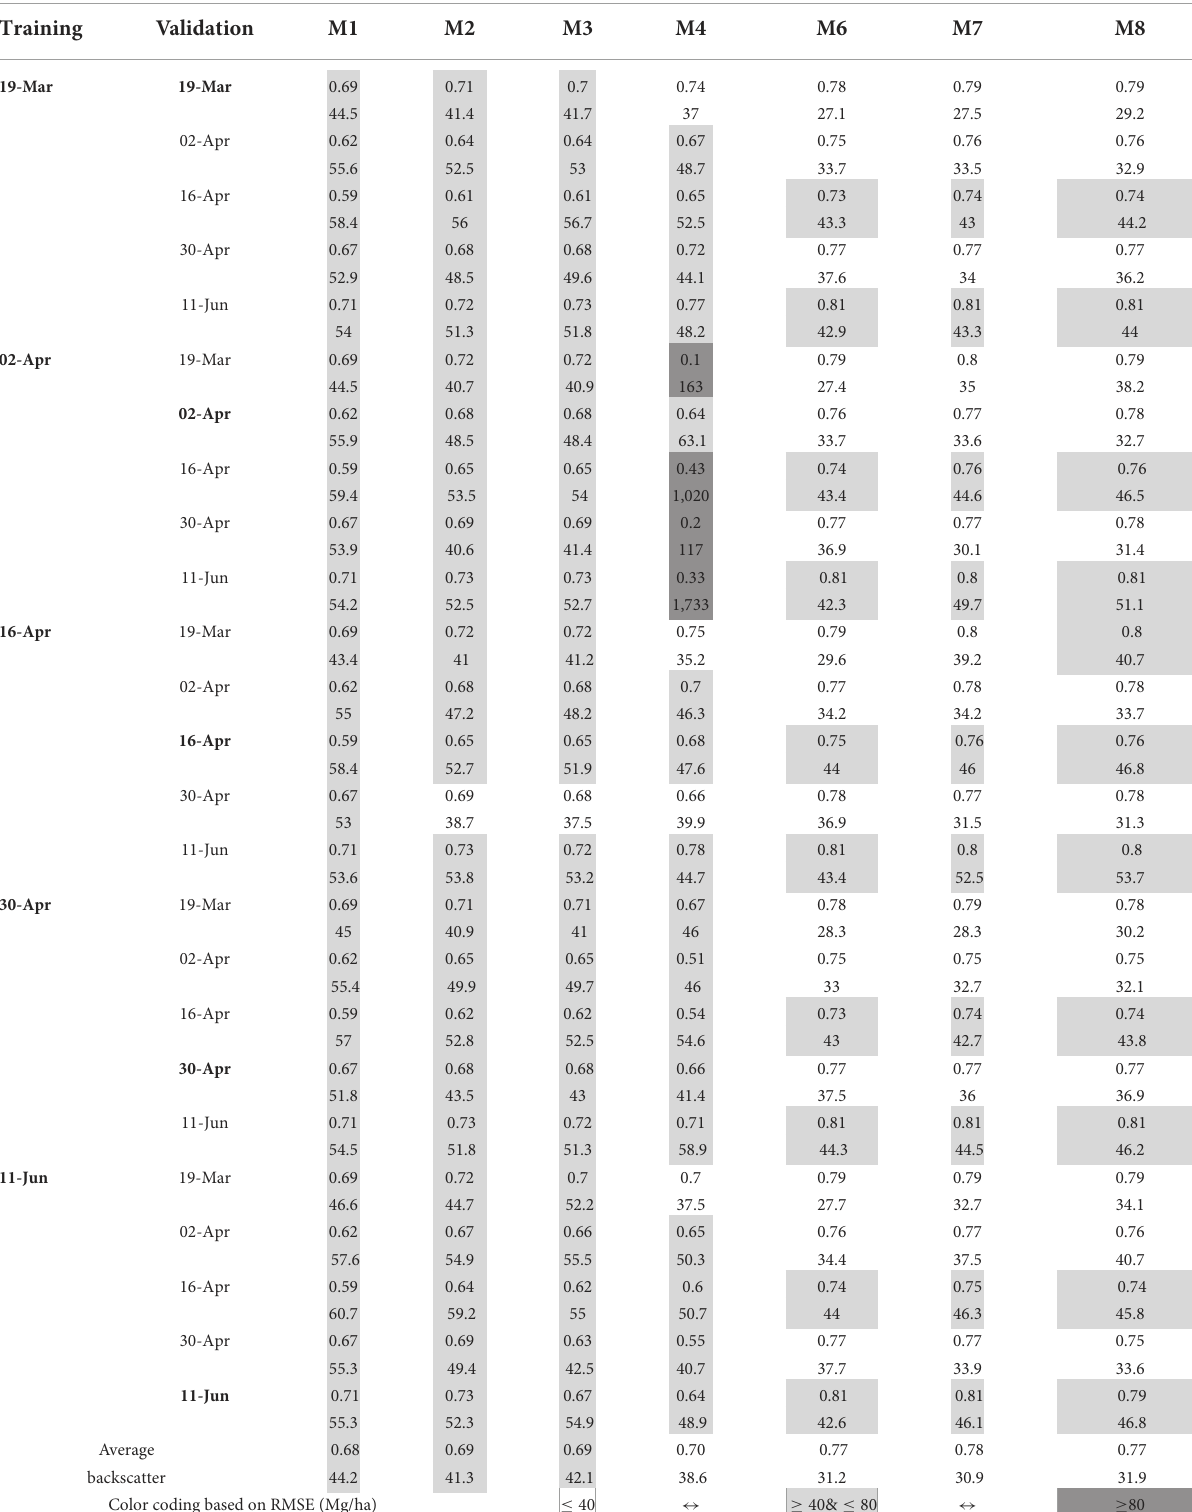
TABLE 2 Temporal validation: Results of validation carried out on Models M1 to M4 (backscatter based) and M6 to M8 (backscatter and height based). Backscatter based Backscatter and height based Training